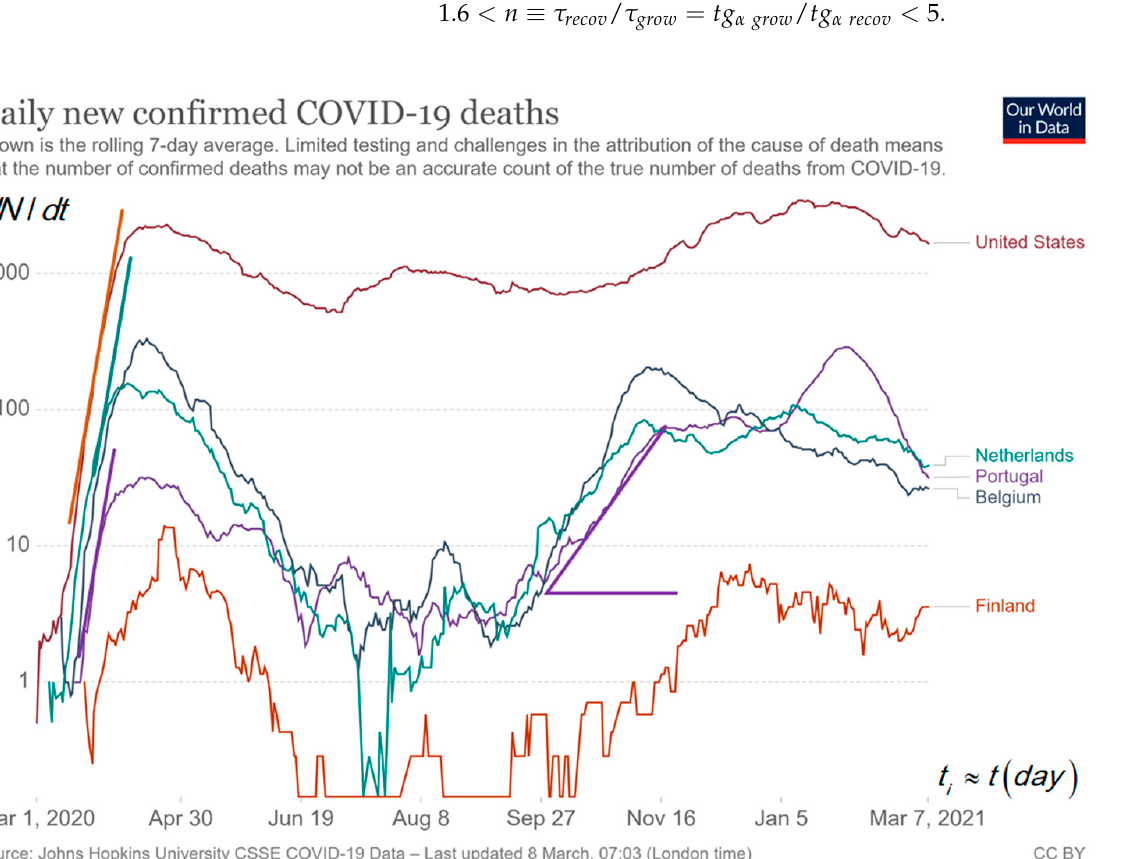
, 𝜏 and 𝑛 = (cid:3034)(cid:3045)(cid:3042)(cid:3050) (cid:3045)(cid:3032)(cid:3030)(cid:3042)(cid:3049)